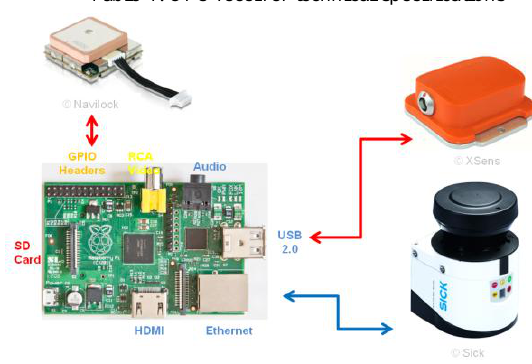
Fig. 10: Rapsberry Pi, Model B and sensors